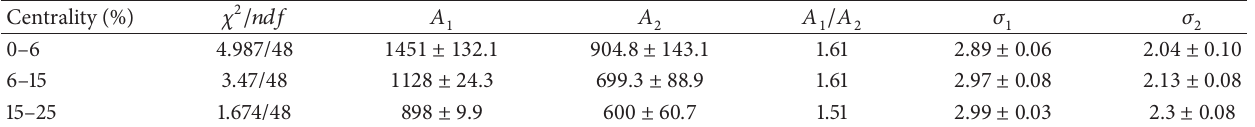
Table 4: PHOBOS Au+Au